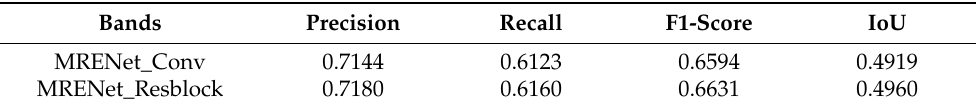
Table 6. Experimental results of road centerline extraction with different connection locations for upsampling ( ρ =